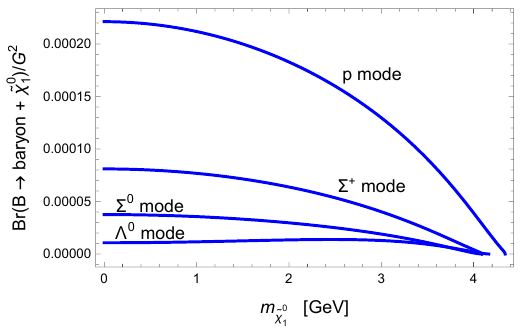
Figure 2 . The branching fractions of B + → p ˜ χ 0 normalized by G 2 = λ 00